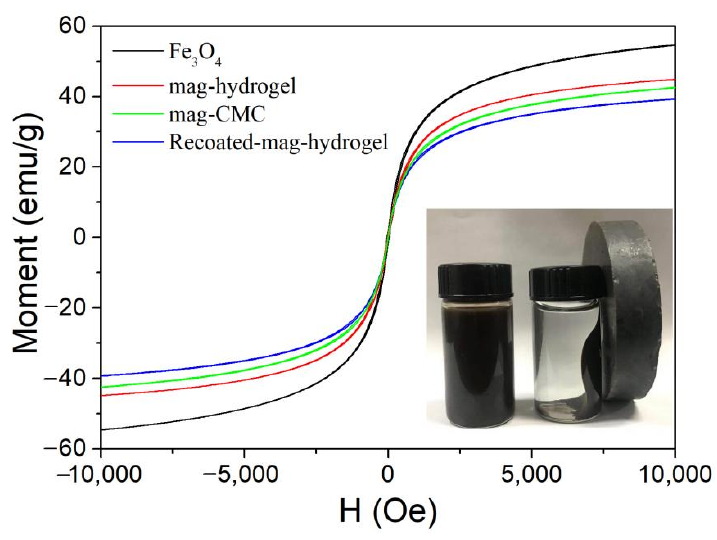
Figure 4. Magnetization curve of Fe 3 O 4 and magnetic nanocomposites.